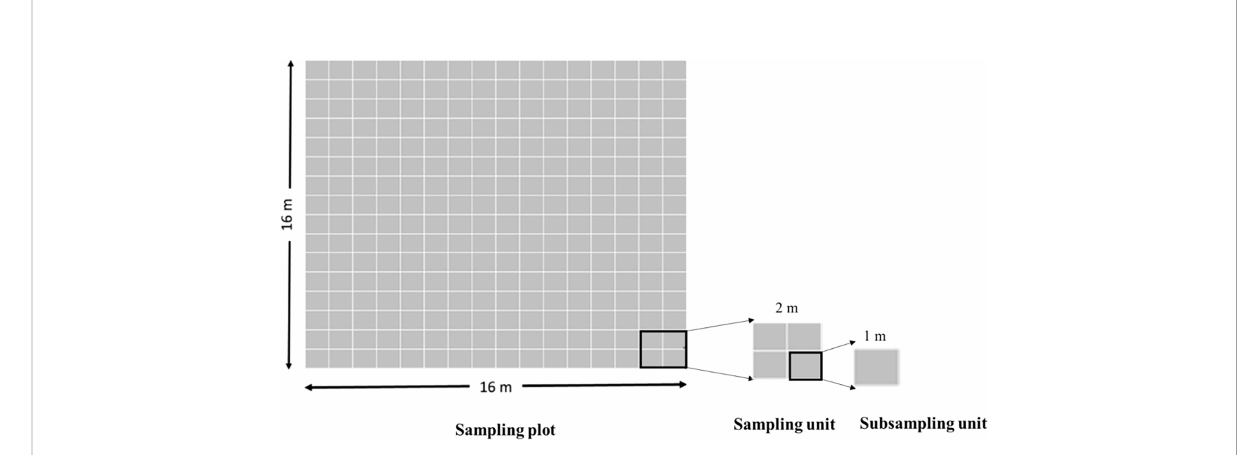
FIGURE 2 The layout of a permanent plot with 64 sampling units (2×2m 2 ) and 256 subsampling units(1×1m 2